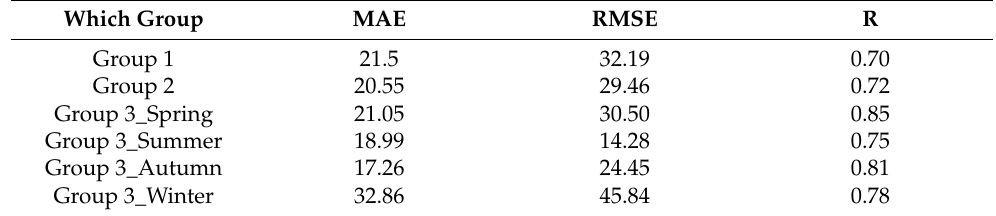
Table 2. Comparison of the prediction performance of the three groups of models on the test set. Which